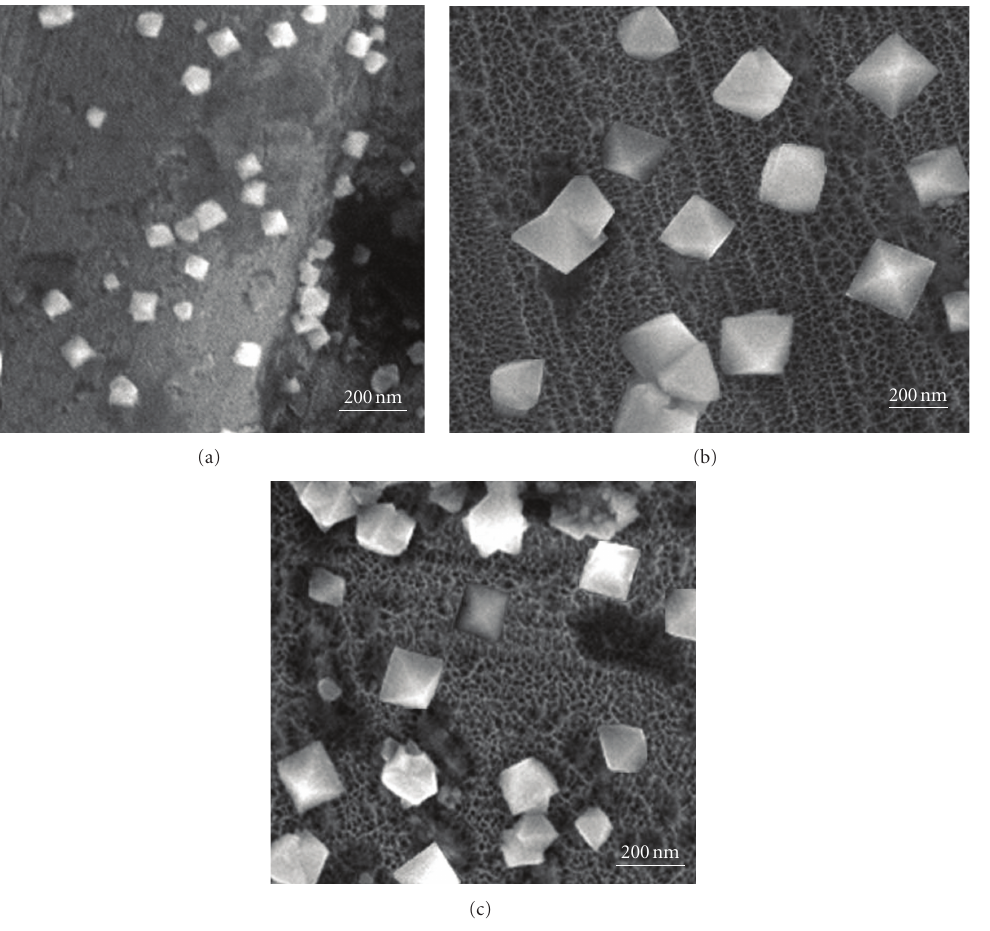
Figure 3: SEM images of the as-deposited specimen with di ff erent mole ratios of lactic acid/CuSO 4 : (a) R = 0 . 75 / 0 . 4; (b) R = 4 . 5 / 0 . 4; (c) R = 6 / 0 . 4 while other parameters are kept